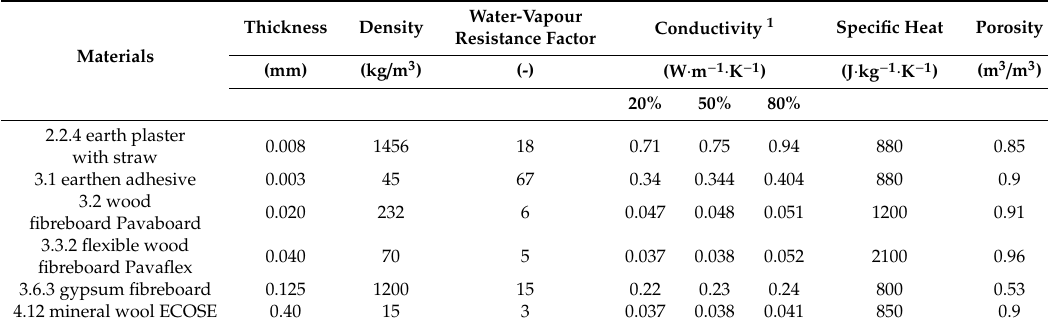
Table 1. Material